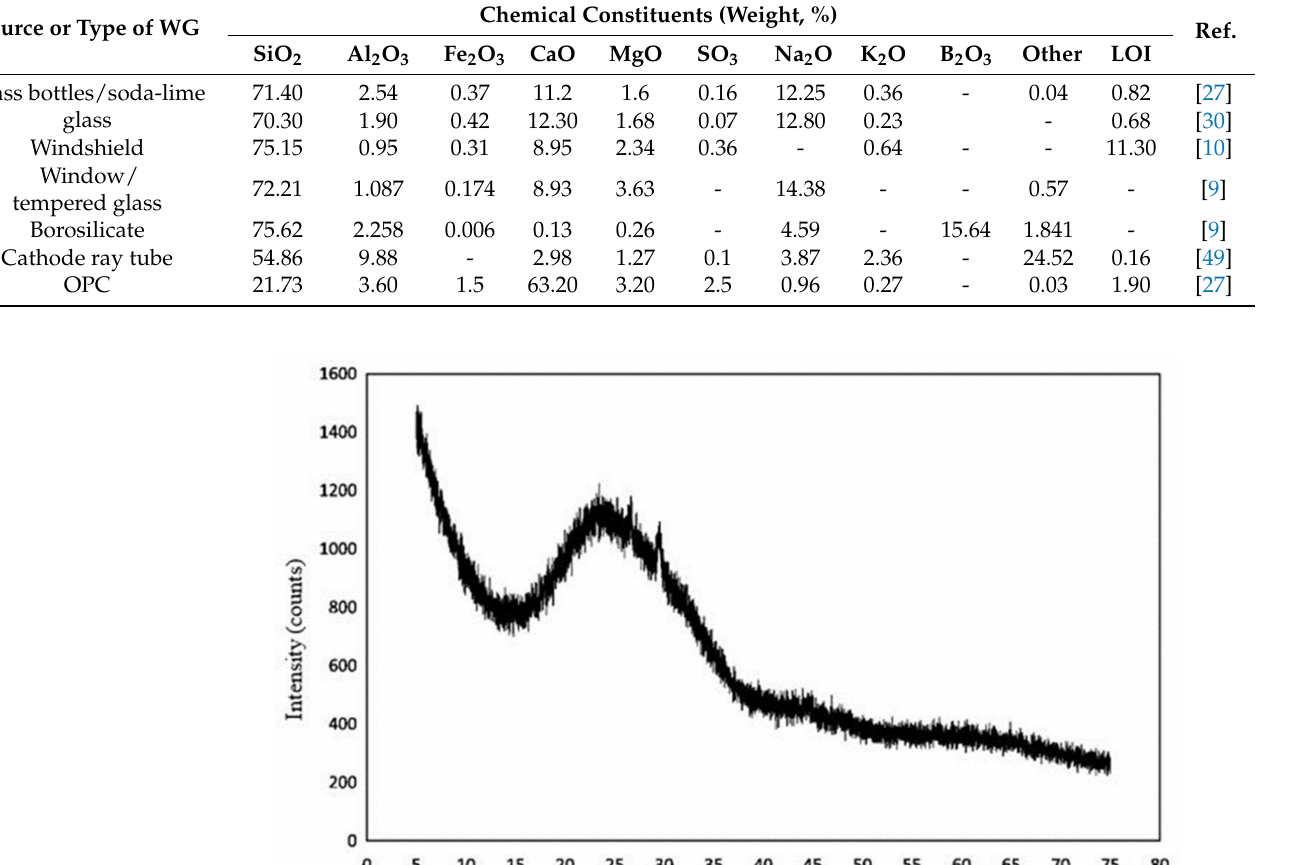
Table 1. Chemical composition of WG and OPC (LOI: loss on ignition).